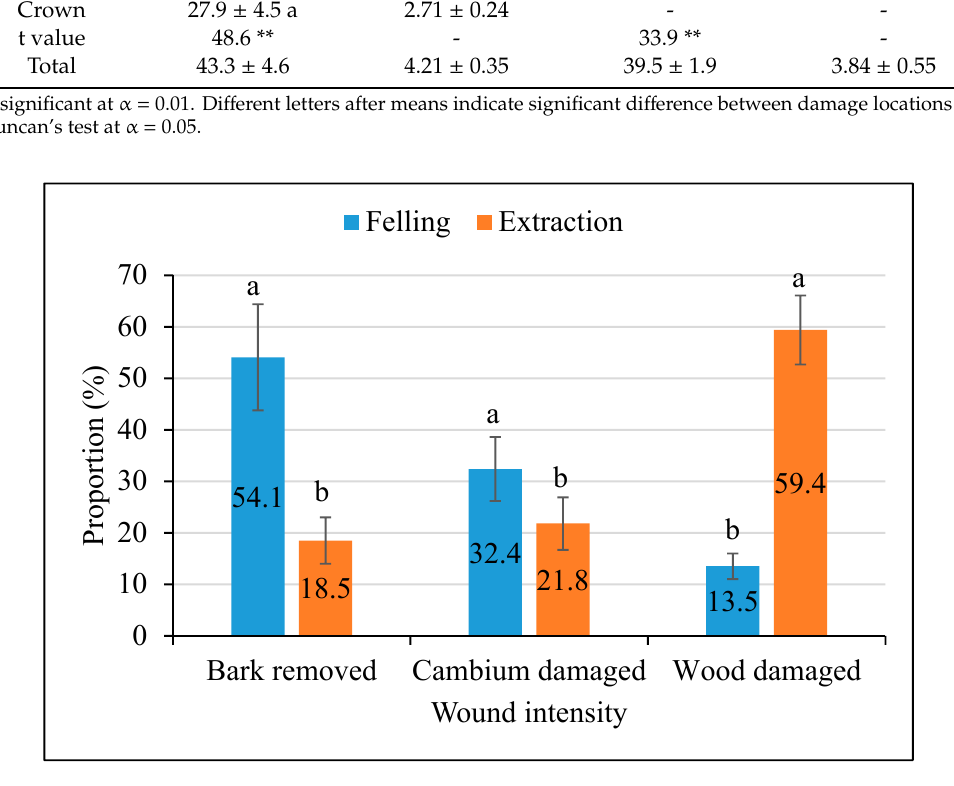
Figure 2. Proportion (%) of felling and extraction phases in the occurrence of bole wounds with different intensities.